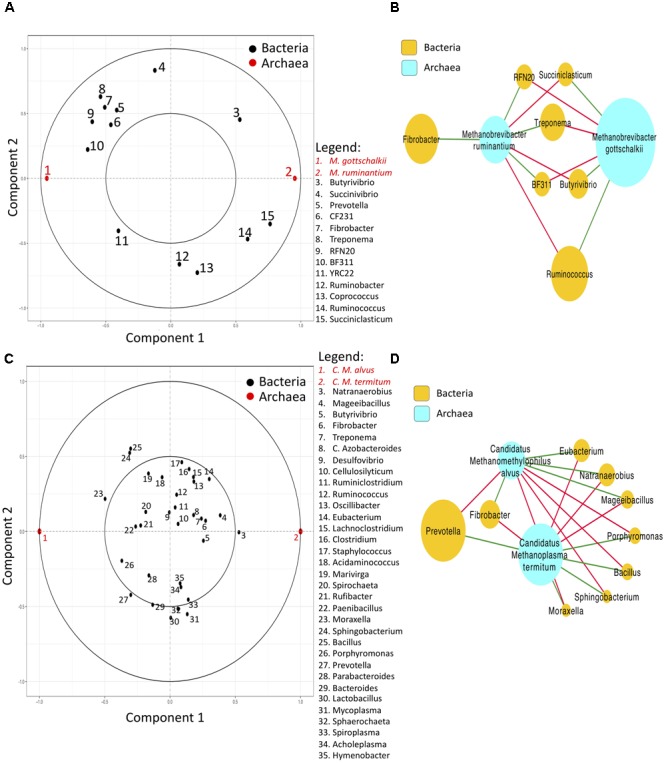
Correlation circle plots and relevance networks generated from the output of regularized canonical correlation (rCC) method (Total Sum Scaling + Centered Log Ratio) applied to rumen bacteria (genera) and archaea (species) classified by Mothur or Kraken. (A,B) show the correlation and network plots of the first two rCC components for Mothur. (C,D) Represent the correlation and network plots of the first two rCC components for Kraken. In the correlation circle plots, bacteria (X) and archaea (Y) are shown inside a circle of radius 1 centered at the origin, with strongly associated (or correlated) variables being projected in the same direction from the origin. The greater the distance from the origin indicates stronger association. Two circumferences of radius 1 and 0.5 are plotted to reveal the correlation structure of the variables (Gonzalez et al., 2008). In the relevance networks, red and green edges indicate positive and negative correlations respectively, and the sizes of the nodes indicate the mean average abundance. Only bacterial genera and archaeal species with a relative abundance > 0.1% detected in all rumen samples were included in the rCC analysis (Li and Guan, 2017).